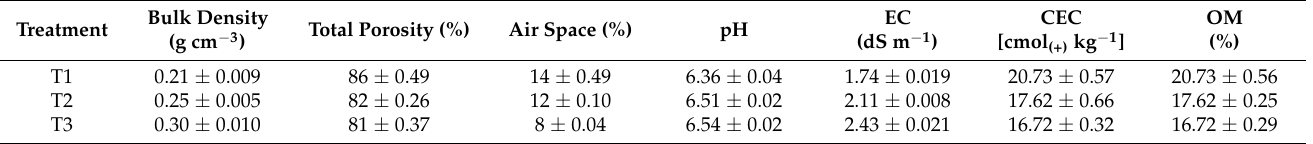
Table 2. Physical and chemical properties of the substrate mixtures composed of peatmoss and compost at different percentages ( v / v ) used to grow lulo ( Solanum quitoense Lam.)